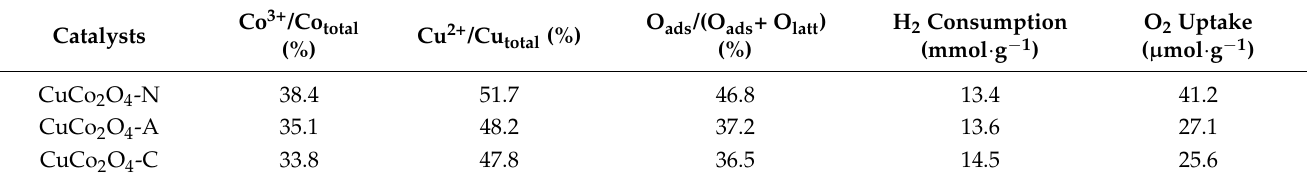
Figure 4. XPS spectra of the CuCo 2 O 4 - x ( x = N, A and C) catalysts: ( a ) Co 2p; ( b ) Cu 2p; ( c ) Cu LMM; ( d ) O 1s. Table 2. Redox properties of the CuCo 2 O 4 - x ( x = N, A and C) catalysts.